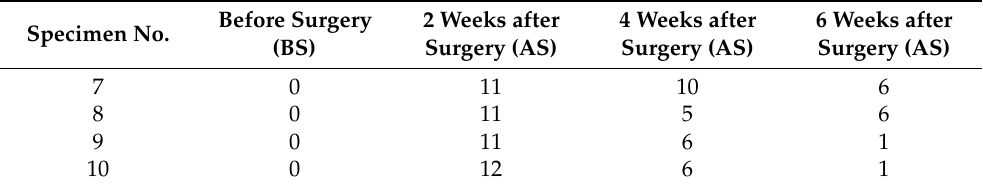
Table 7. Clinical score distribution across group two.